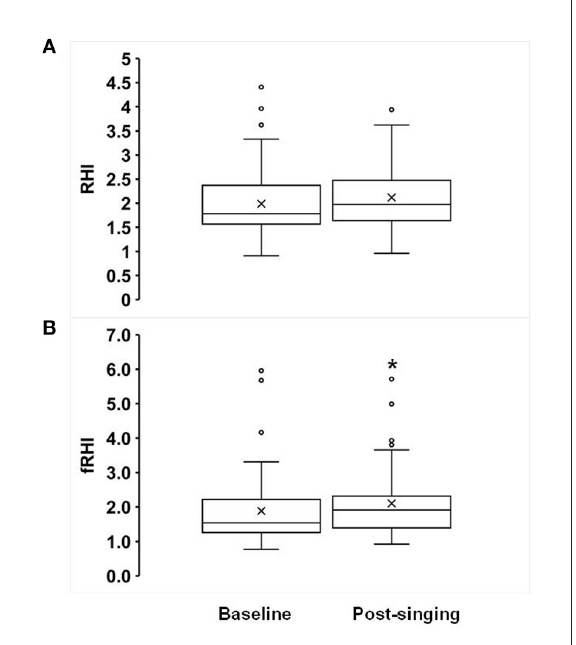
FIGURE1 Effects of singing on Reactive Hyperemia Index (RHI, A ) and Framingham RHI (fRHI, B ). Box plots showing the following values: the mean (x), median, upper quartile (Q3), lower quartile (Q1), minimum and maximum whiskers as well as outliers. * p <